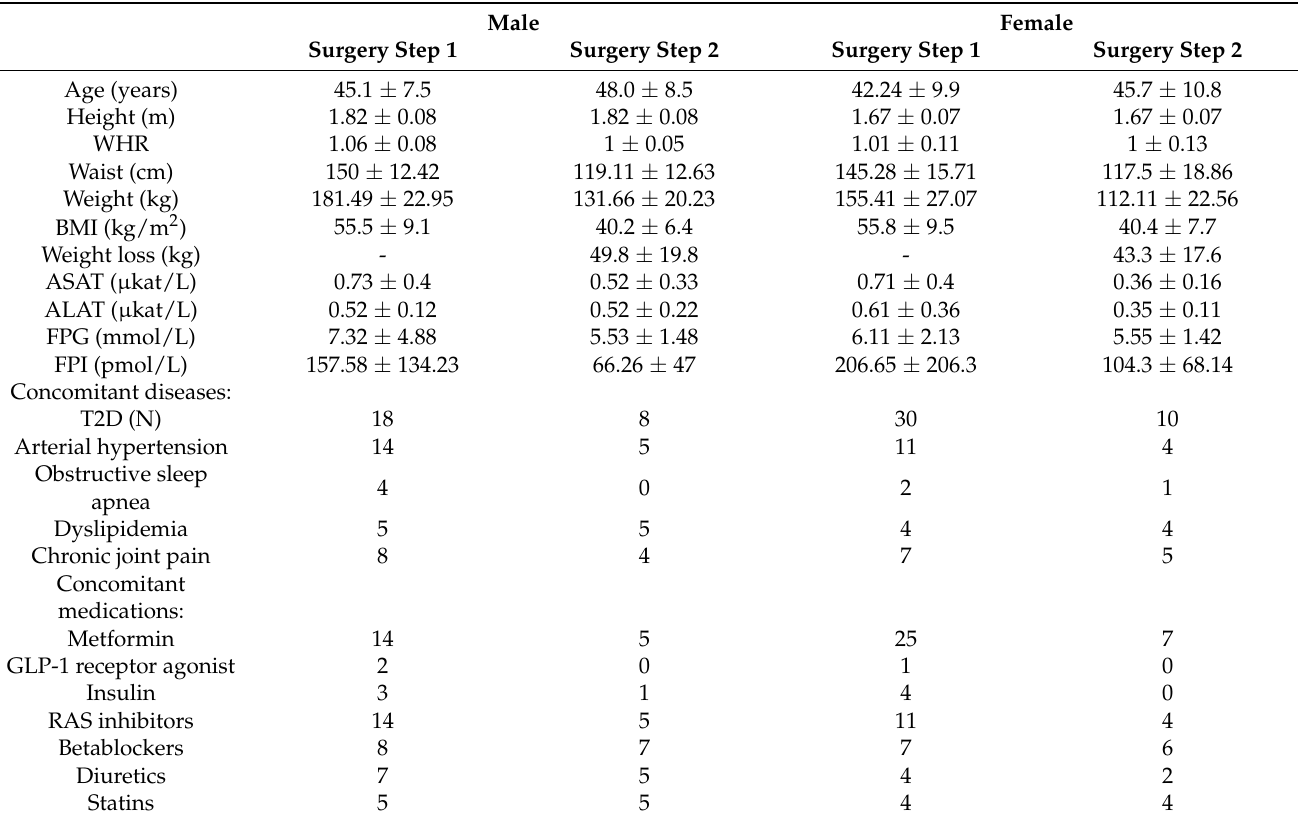
Table 3. Cohort 2 patient